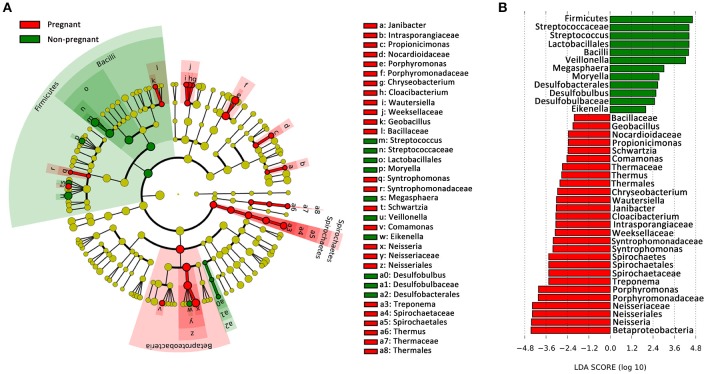
Bacterial phylotypes whose abundances were changed with pregnancy, as identified by LEfSe. (A) A cladogram for taxonomic representation is shown in the panel. Red indicates enrichment in samples from pregnant women, and green indicates the taxa enriched in the samples from non-pregnant women. (B) A histogram of the linear discriminant analysis (LDA) scores was calculated for the selected taxa.